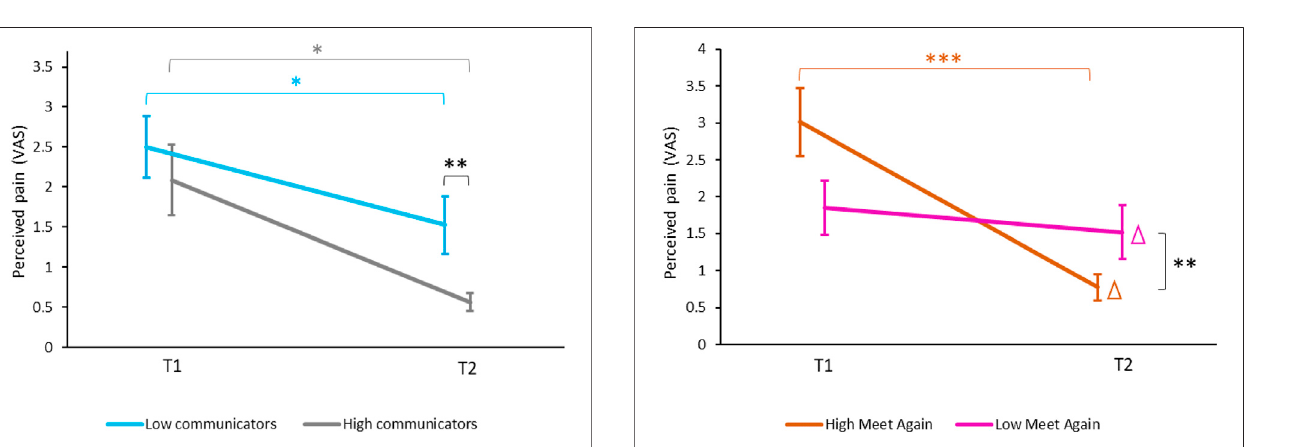
FIGURE 6 | Differences in mild-pain ratings between high communicators (HC) and low communicators (LC). Pain ratings decreased at T2 compared to T1 in both the HC (* p < 0.05, gray) and the LC groups (* p < 0.05, blue). However, at T2 pain ratings by HC were signi fi cantly lower than ratings by LC (** p < 0.01). Values denote mean visual-analogue scale (VAS) ratings (0 – 10) ± SEM. T1 — before encountering PARO, T2 — while touching PARO. HC — participants who gave above-median ratings to their abilitytocommunicate withPARO.LC — participantswhogavebelow-median ratings to their ability to communicate with PARO.